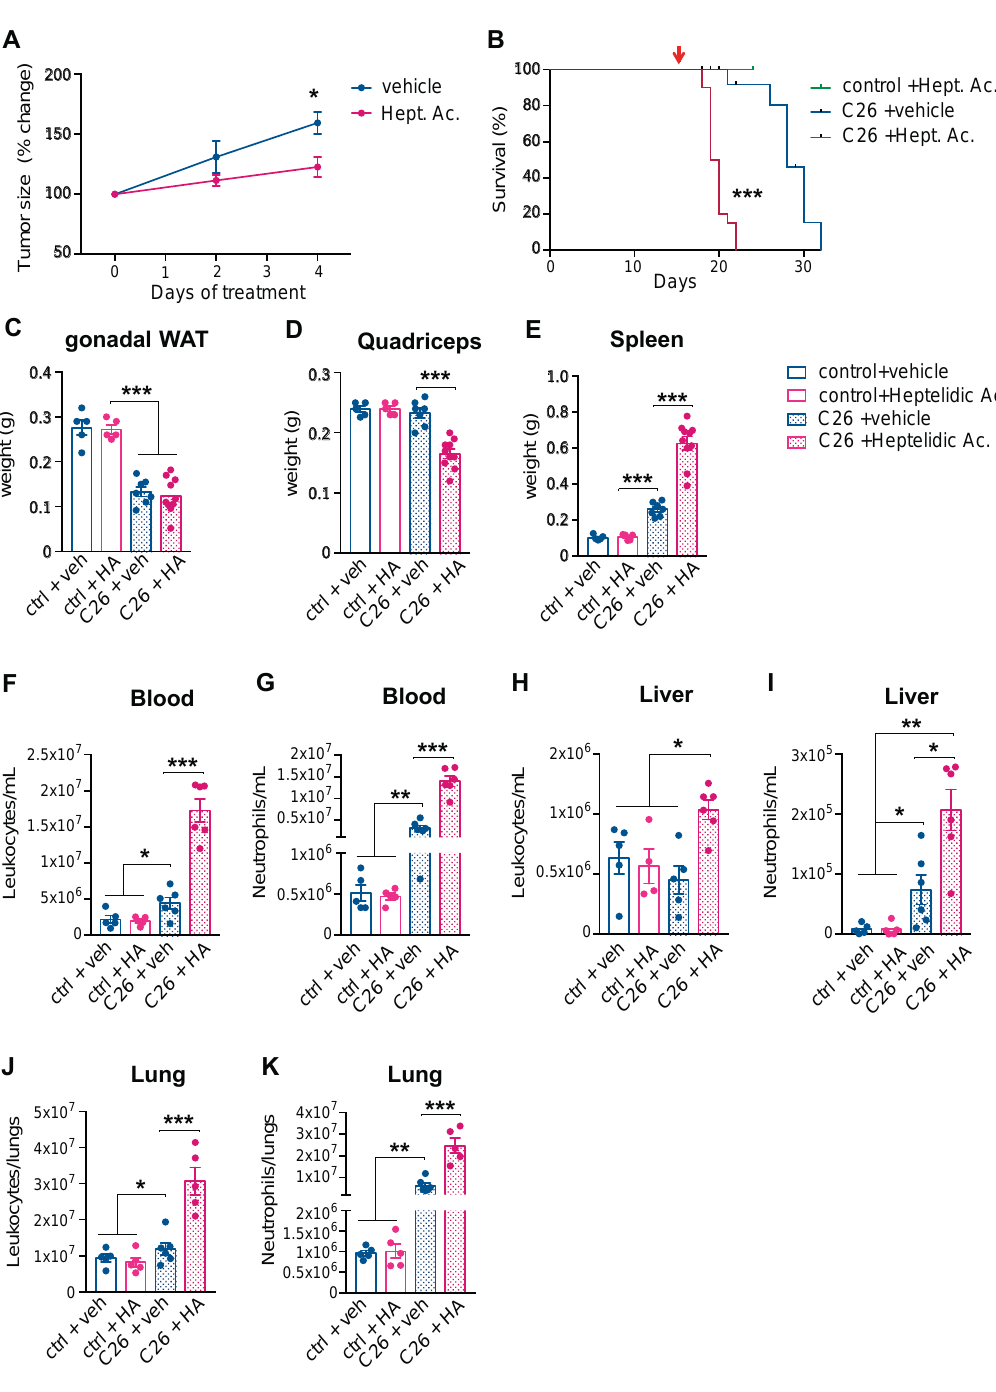
Figure 4. Effects of systemic inhibition of aerobic glycolysis on the severity of cancer cachexia. ( A ) Longitudinal tumor measurements of the C26 mice that were treated with heptelidic acid or the vehicle. The red arrow indicates start of treatment; ( B ) Overall survival of the C26 mice and littermates treated with heptelidic acid or vehicle; ( C – E ) The tissue weights of gonadal white adipose tissue (gWAT) ( C ), quadriceps ( D ), and spleen ( E ) of time-matched mice in ( A ); ( F – K ) Quantification of leukocyte ( F , H , J ) and neutrophil ( G , I , K ) counts in the circulation ( F , G ), the liver ( H , I ), and the lungs ( J , K ) of mice in ( A ). The data are expressed as the mean ± SEM. Unpaired two-tailed Student’s t -tests were performed at each time point in ( A ), with the Holm–Šid á k method correction for multiple comparisons. Kaplan–Meier curves in ( B ) were statistically analyzed by using the log-rank (Mantel– Cox) test. A one-way ANOVA with Tukey’s correction for post hoc testing was used in ( C – K ). * p -value < 0.05, ** p -value < 0.01, *** p -value <